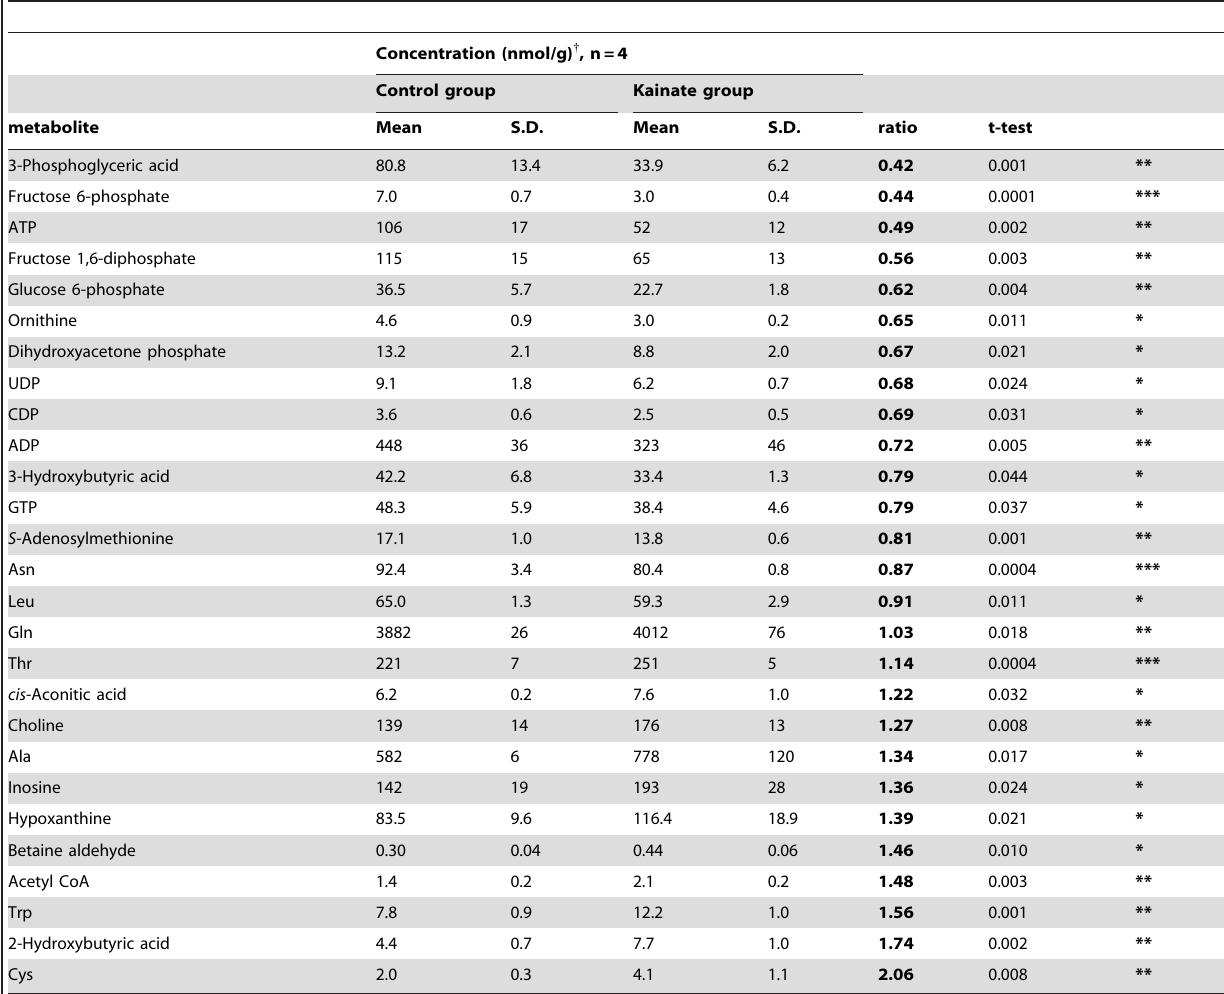
Table 1. Results of quantitative CE-MS metabolomics comparing 27 metabolites which showed significant change between control and kainate-treated mouse brain